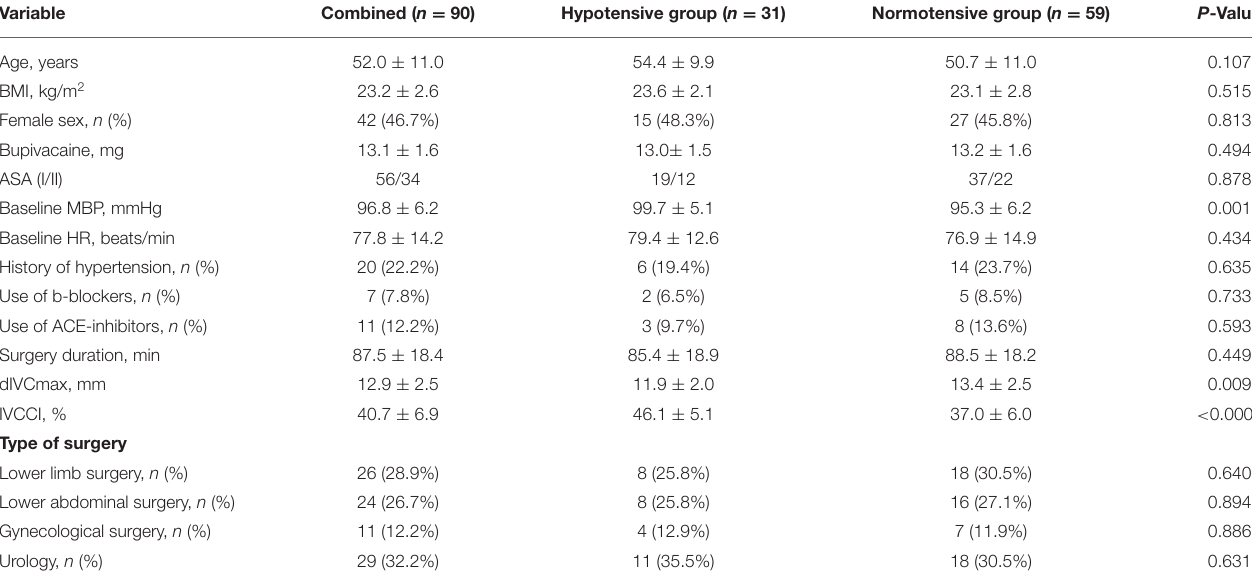
TABLE 1 | Demographic and perioperative characteristics of patients.